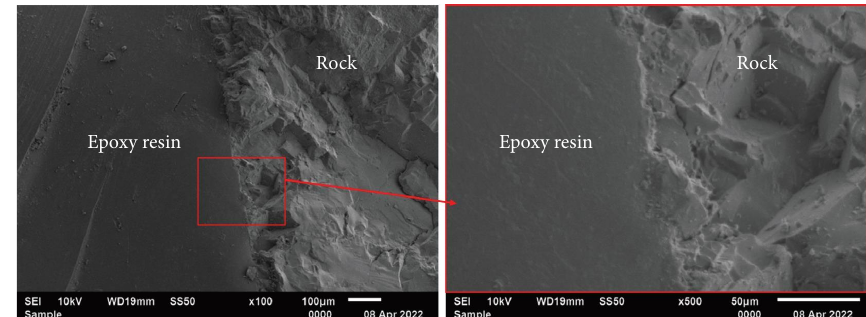
Figure 27: SEM image of the failed bond surface with 28d of curing.